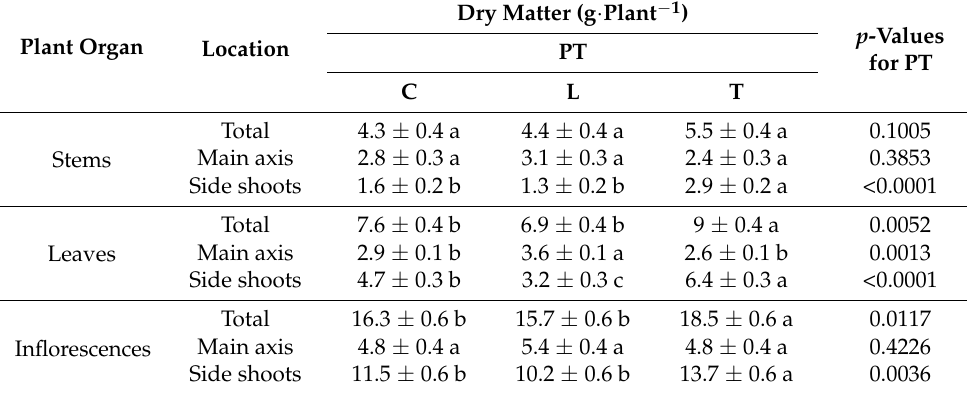
Table 2. Least square means ( ± standard error) of dry matter (g · plant − 1 ) in different plant organs (stem, leaves and inflorescences) and locations (total, main axis and side shoots) for each pruning technique (PT). For each plant organ and location, means with at least one identical letter are not significantly different from each other according to Fisher ´ s LSD test with α = 0.05. Pruning techniques (C—control; L—lollipop; T—topping). Note that p -values correspond to F-test within an ANOVA.